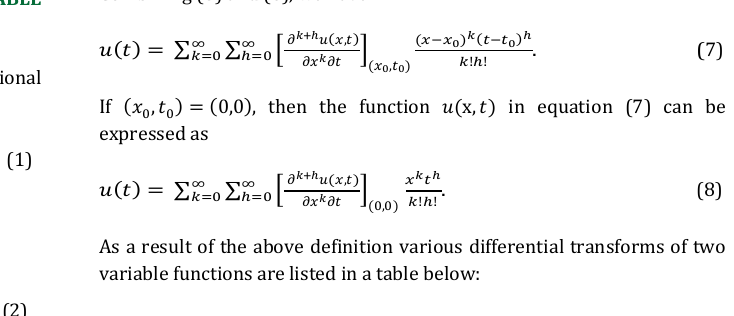
Table 2: Various differential transformations of two